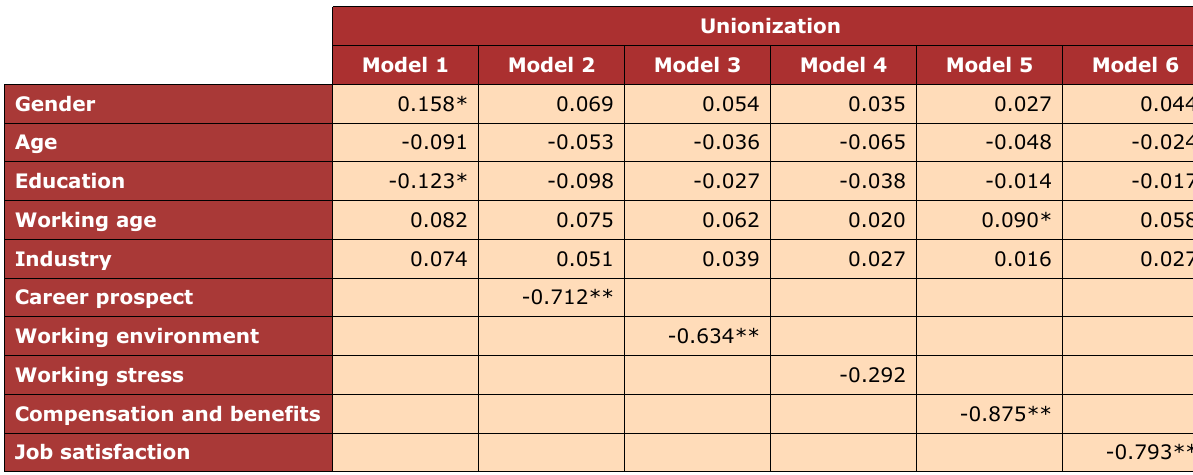
Table 2. Regression analysis for the effect of job satisfaction on